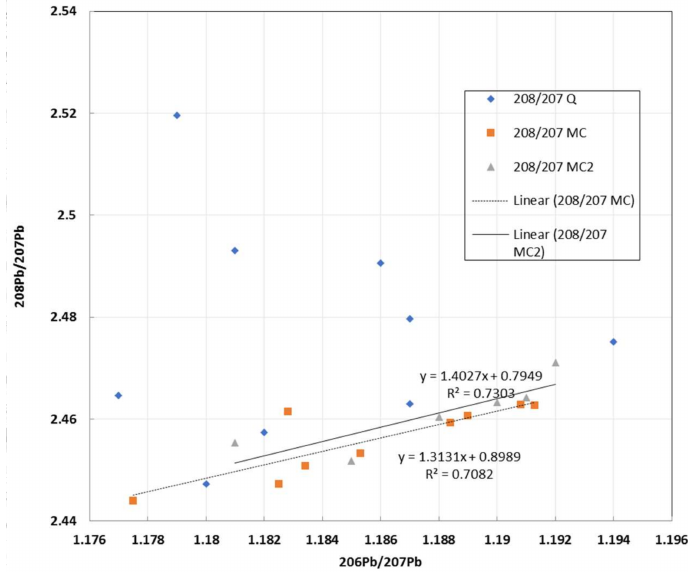
Figure 6. Comparison of Q-ICP-MS and multi-collector plasma mass spectrometry (MC-ICP-MS) data for peat bogs from Canada and Scotland (data from [31]) showing the lack of discrimination for the earlier Q-ICP-MS data. MC 1 and 2 data are for different